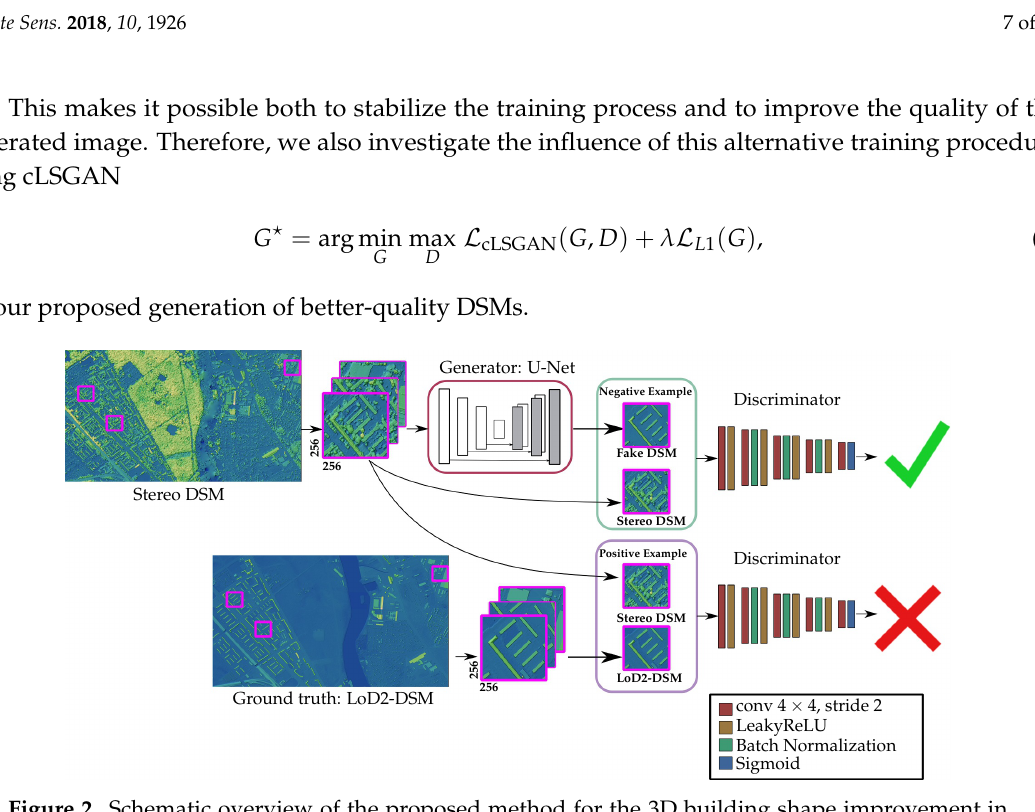
Figure 2. Schematic overview of the proposed method for the 3D building shape improvement in stereo DSM by cGAN. The DSM images are color-shaded for better